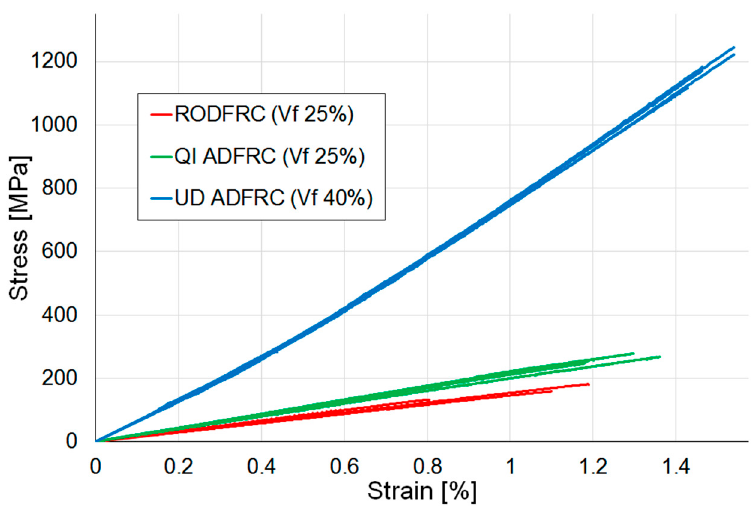
Figure 3. Tensile stress-stain curves for 100% HSC discontinuous fibre composites.